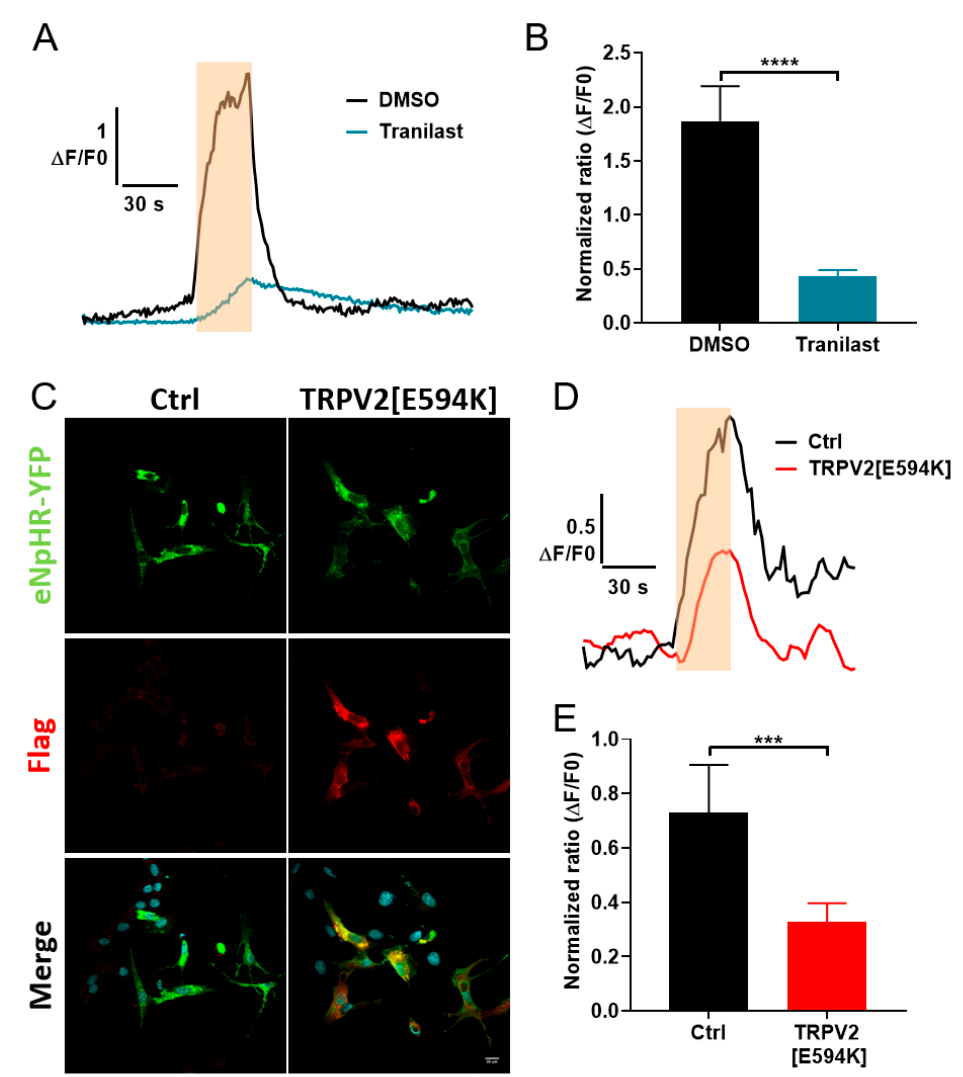
Figure 4. Involvement of TRPV2 channels in the mediation of constitutive calcium entry during light stimulation. ( A ) Representative traces of Fura-2 normalized ratio in response to a light stimulation of 30 s at 48 mW / cm 2 (orange rectangle) in C2C12 myoblasts expressing eNpHR-YFP treated with DMSO 1 / 1000 (vehicle) or with 100 µ M Tranilast, a TRPV2 inhibitor. ( B ) Maximum amplitude ( ∆ F / F0) of the Fura-2 fluorescence response to light stimulation in eNpHR-expressing C2C12 myoblasts treated with DMSO 1 / 1000 ( n = 4 0) or with 100 µ M Tranilast ( n = 45). ( C ) Confocal images showing immuno-expression of the negative-dominant TRPV2[E594K] tagged with a flag sequence (red) co-transfected (TRPV2[E594K] right panels) or not (Ctrl, left panel) with eNpHR-YFP (green) in C2C12 myoblasts. ( D ) Representative traces of normalized Fura-2 ratio during a light stimulation of 30 s at 48 mW / cm 2 (orange rectangle) in C2C12 myoblasts expressing eNpHR-YFP co-transfected (TRPV2[E594K]) or not (Ctrl) with the negative-dominant TRPV2[E594K]. ( E ) Maximum amplitude ( ∆ F / F0) of the Fura-2 fluorescence response to light stimulation in control C2C12 myoblasts expressing eNpHR-YFP (Ctrl, n = 31) or in C2C12 myoblasts expressing eNpHR-YFP co-transfected with negative-dominant TRPV2[E594K] (TRPV2[E594K], n = 102). Data are presented as mean ± SEM. *** and **** represent significant di ff erences with p < 0.001 and p < 0.0001, respectively (Mann–Whitney